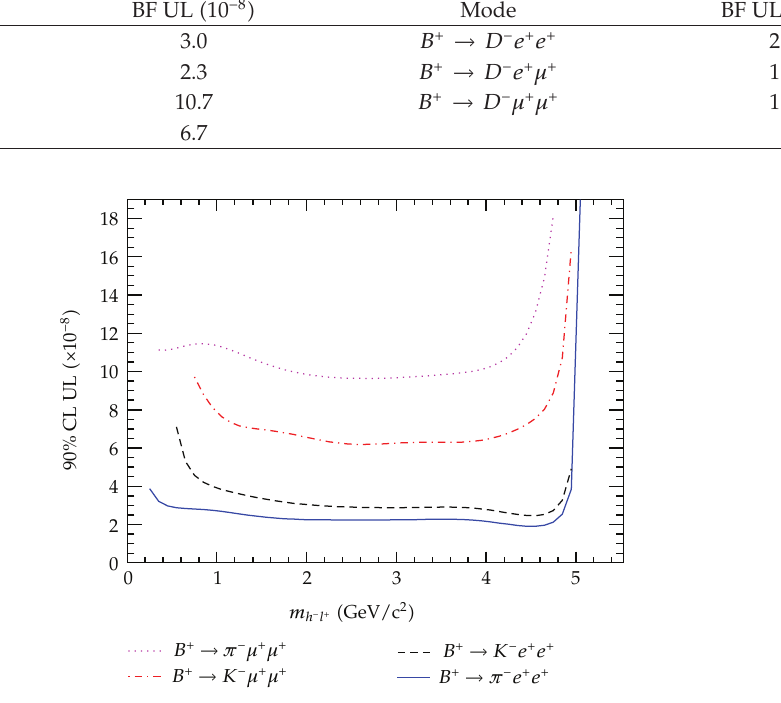
Figure 7: 90% CL upper limits (cid:2) UL (cid:3) on the branching fraction B (cid:2) B (cid:8) → h − l (cid:8) l (cid:8) (cid:3) as a function of the h − l (cid:8) mass (cid:2) m h − l (cid:8) (cid:3) derived by BABAR